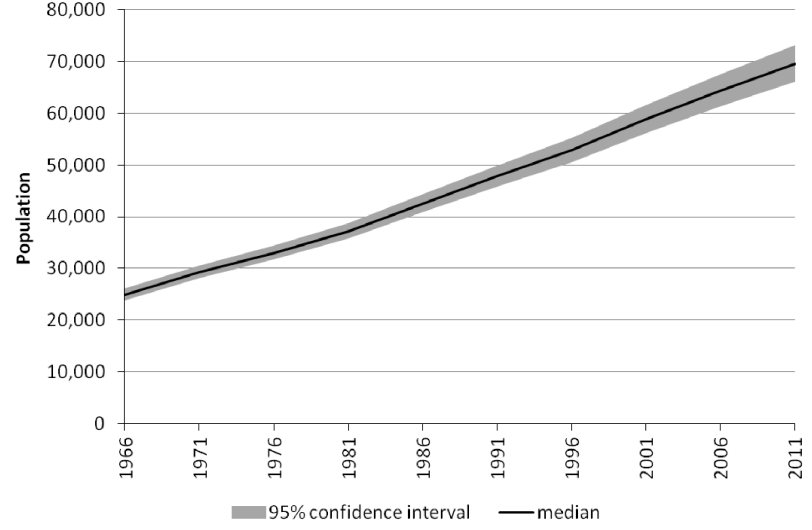
Figure 6. Estimates of the Northern Territory Indigenous population, 1966–2011.